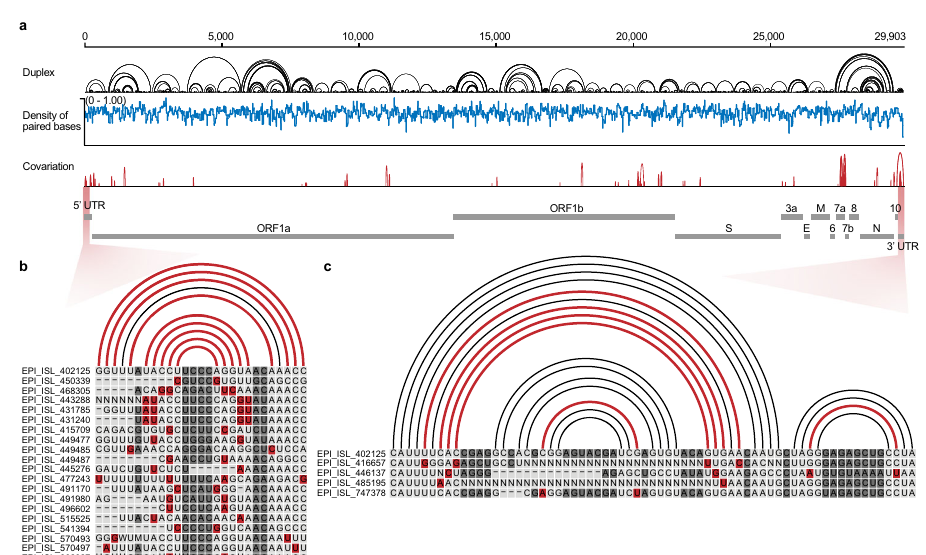
Fig. 5 Co-variation among duplexes in different SARS-CoV-2 strains. a Pro fi le of structural elements and variants in the SARS-CoV-2 genome. The black arc lines stand for base pairs, the blue line indicates the density of base-paired nucleotides, and the red arc lines denote co-variant base pairs among different SARS-CoV-2 strains. b , c Co-variant base pairs in the 5 ′ UTR ( b ) and 3 ′ UTR ( c ), respectively. Arc lines and nucleotides colored in red indicate co- variant base pairs. EPI_ISL_402125 is the reference SARS-CoV-2 sequence.